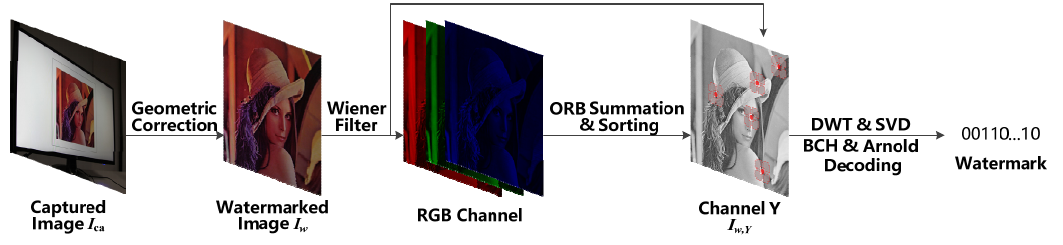
Figure 7. The watermark extraction steps.